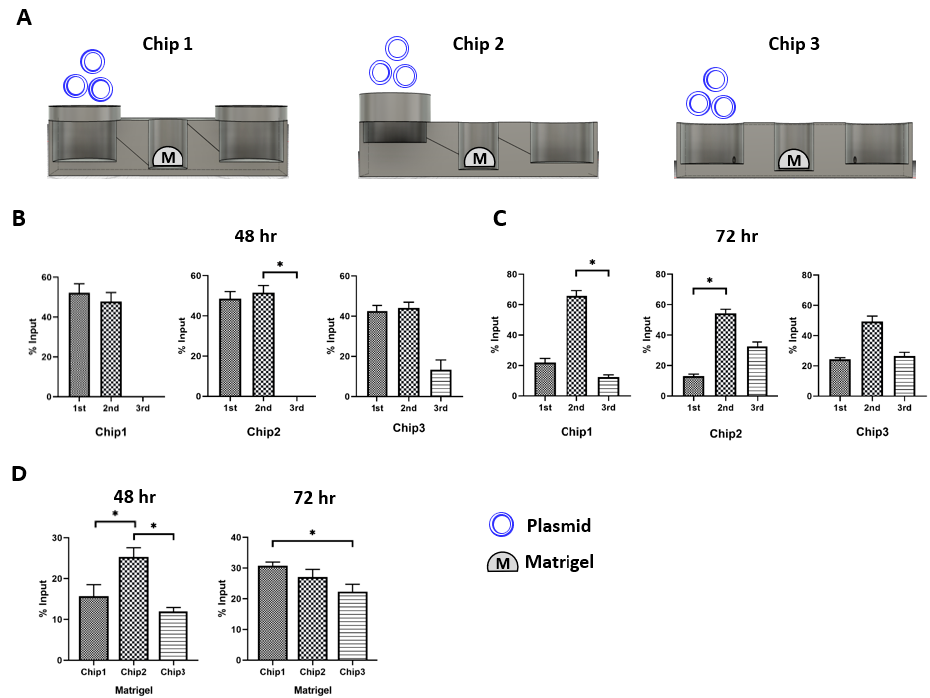
Figure 3. Plasmid distribution test. The plasmid was injected in the first injection well, and the distribution of plasmid was measured at 48 h and 72 h after locating the organoid in the second well. In Chip 2, The Matrigel had the highest plasmid concentration in Chip 2 ( p < 0.05). The only scant amount of plasmid was counted in the third well at 48 h. Then, the plasmid in the second well was transferred to the third well at 72 h. There was no specific difference in the pattern of plasmid distribution at 72 h among the three chip prototypes. Scheme of the simulation assay ( A ), plasmid distribution after 48 h ( B ) and 72 h flow ( C ), comparison of plasmid concentration in the Matrigel of second well at 48 h and 72 h ( D ). The differences were considered significant at p < 0.05 (*).